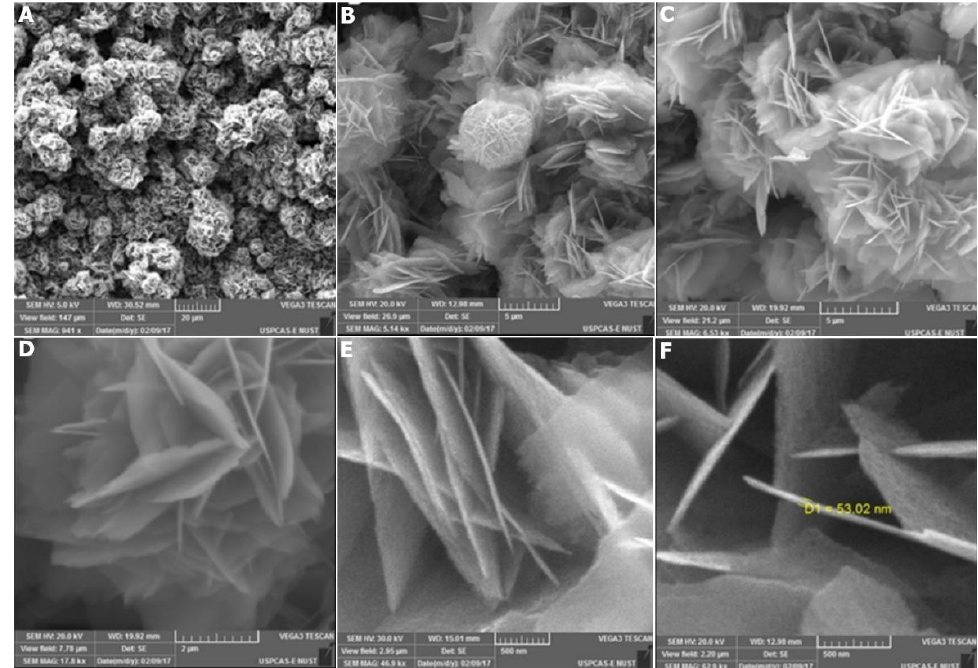
Figure 7. SEM images representing different magnifications of ZnO nanoflowers (( A ) 20 µm, ( B , C )—5 µm, ( D ) 2 µm, ( E , F )—0.5 µm,) grown on FTO via the hydrothermal technique.